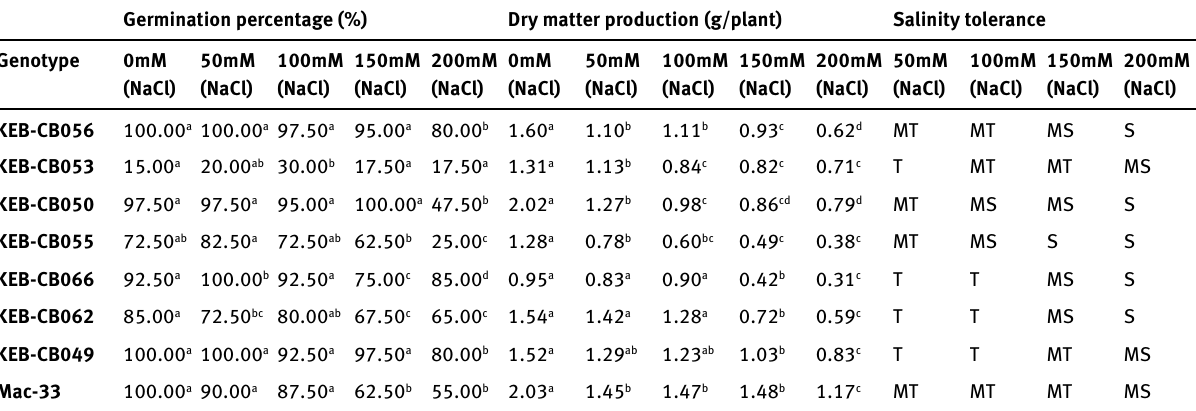
Table 4: Effect of salinity on germination and dry matter production of 8 common bean genotypes at 6 weeks growth and their classification according to salinity Germination percentage (%) Dry matter production (g/plant)